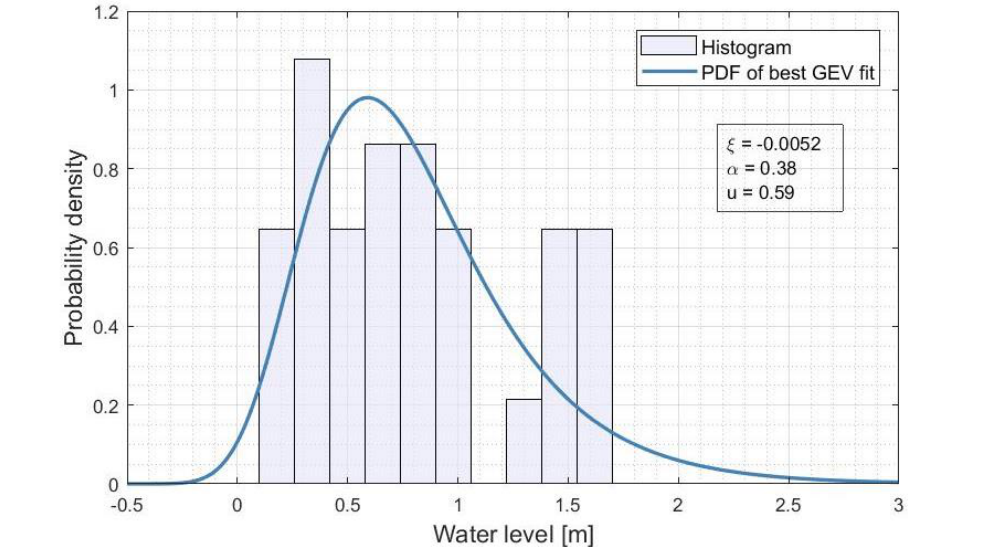
Figure A2. The probability density function according to the GEV based on the 5% quantiles of the water